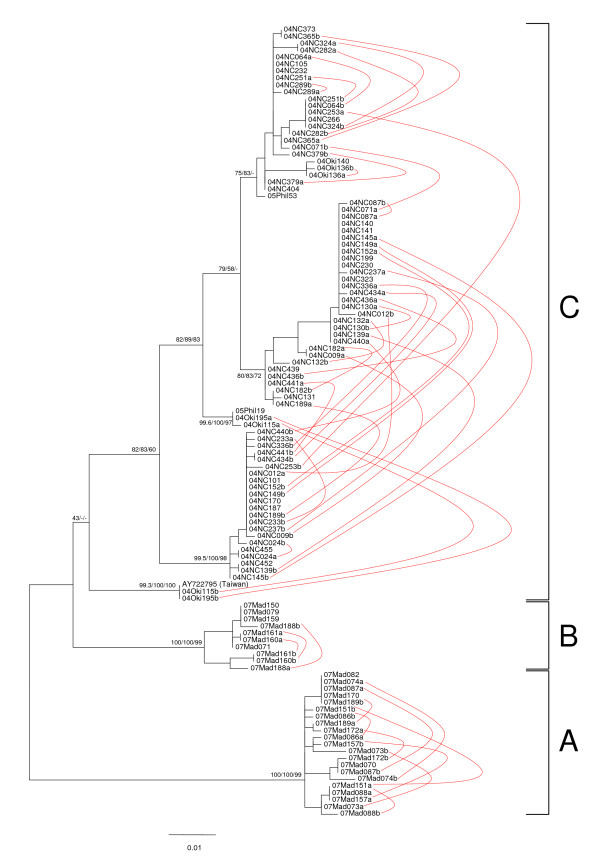
Haploweb of ITS2 sequences. This graph was derived from a phylogenetic tree (obtained with PhyML using the TIM2+G model suggested by jModelTest) by drawing curves connecting haplotypes found co-occurring in heterozygous individuals [9]. The sequence of one Stylophora pistillata individual from the Penghu Islands near Taiwan [35] is included in the figure, and bootstrap values obtained using maximum likelihood, neighbor-joining and parsimony (1000 replicates each) are displayed next to each node. The position of the root was inferred from the mitochondrial DNA phylogeny (Figure 3). This approach delineated three reproductively isolated pools of Stylophora sequences, labeled A, B and C as each of these groups corresponded to one of the mitochondrial clades of Figure 3.